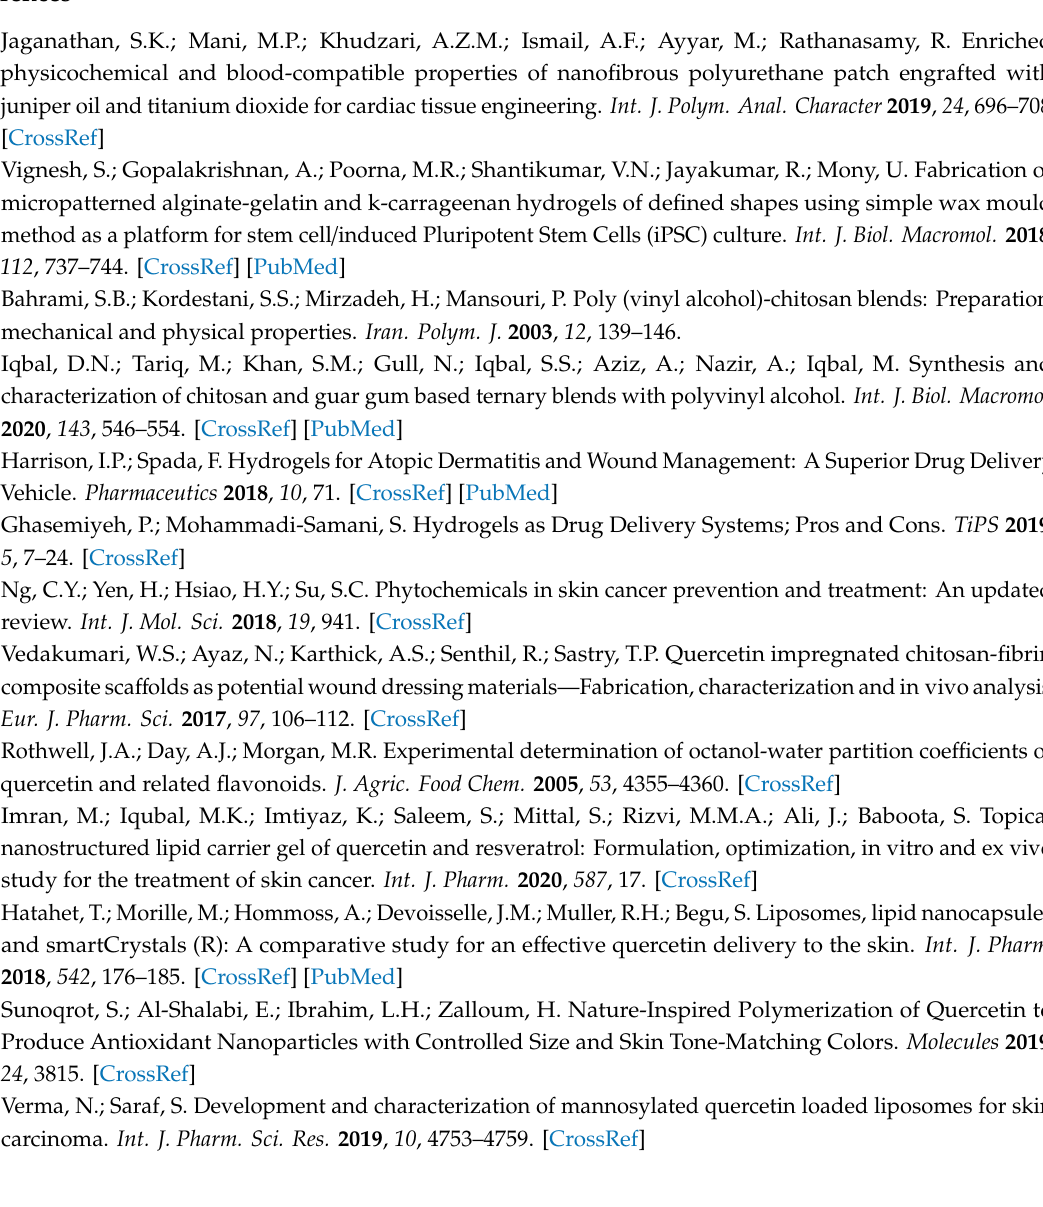
Figure S1: Resistance to temperature ramp from 20 to 40 ◦ C of unloaded (top line) and quercetin-loaded (bottom line) hydrogels; Figure S2: Quercetin permeation profile through the isolated SC